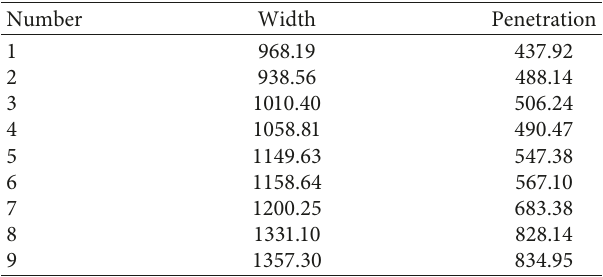
Table 3: The results of welding penetration and width ( µ m).